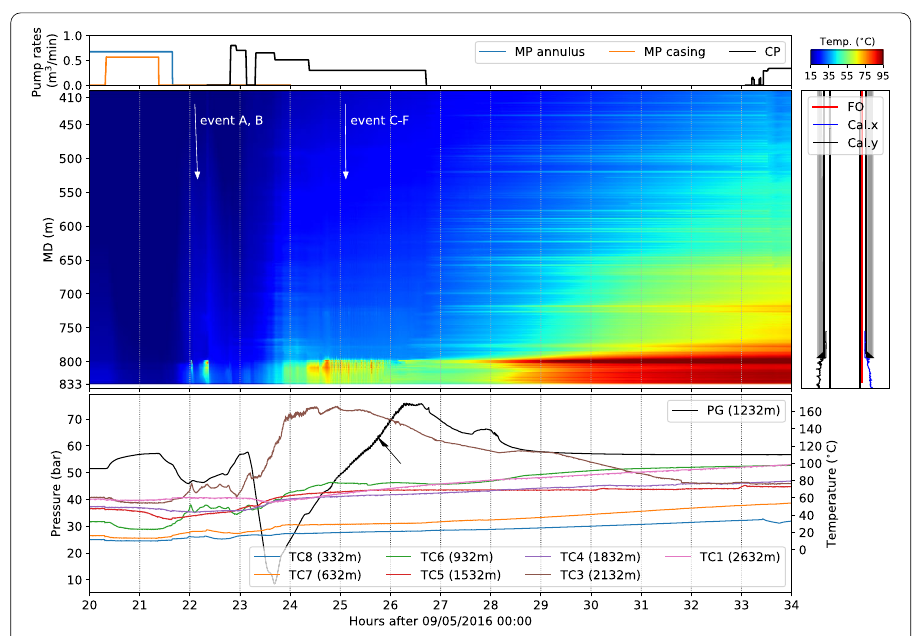
Fig. 5 Overview of downhole data which was acquired during the reverse cement job of the 9 5/8” x 9 7/8” production casing in